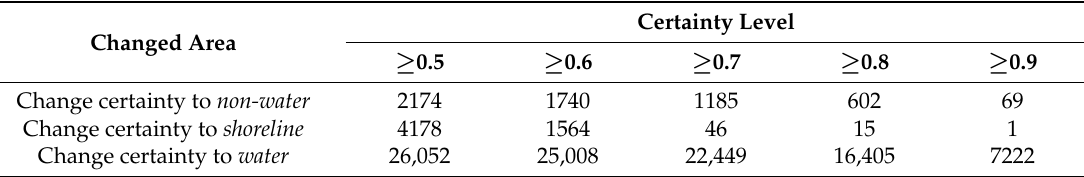
Table 6. Changed area (in number of pixels) between shoreline margin, water and non-water at different levels of certainty for the east section.